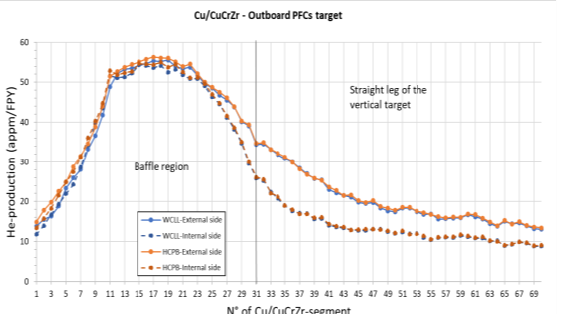
Figure 43. Outer poloidal profiles of the He-production (appm/FPY) on Cu/CuCrZr components,